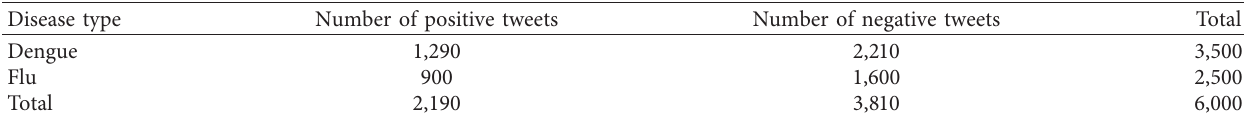
Table 3: The number of labelled tweets split over dengue and